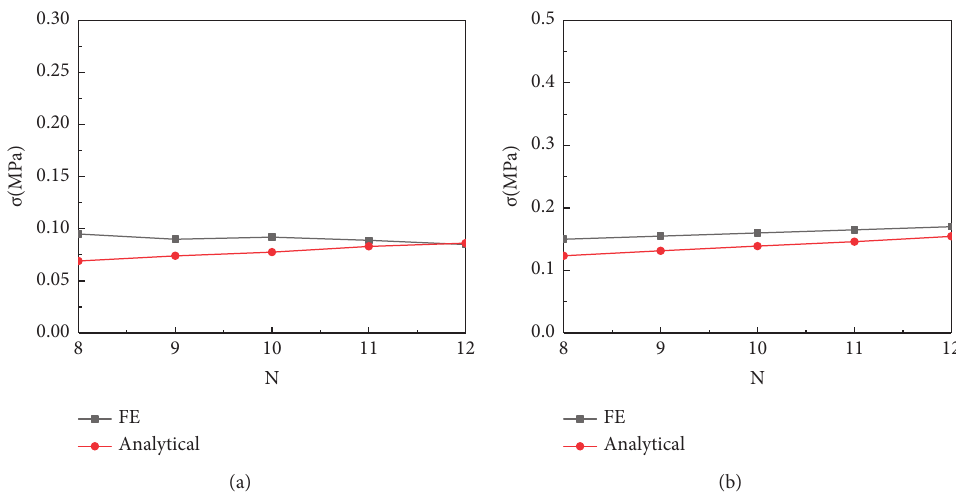
Figure 12: The quasi-static collapse stress of DHHs under uniaxial compression, N � 8 ∼ 12 and ρ � 5%. (a) Impact in the x direction. (b) Impact in the z direction.